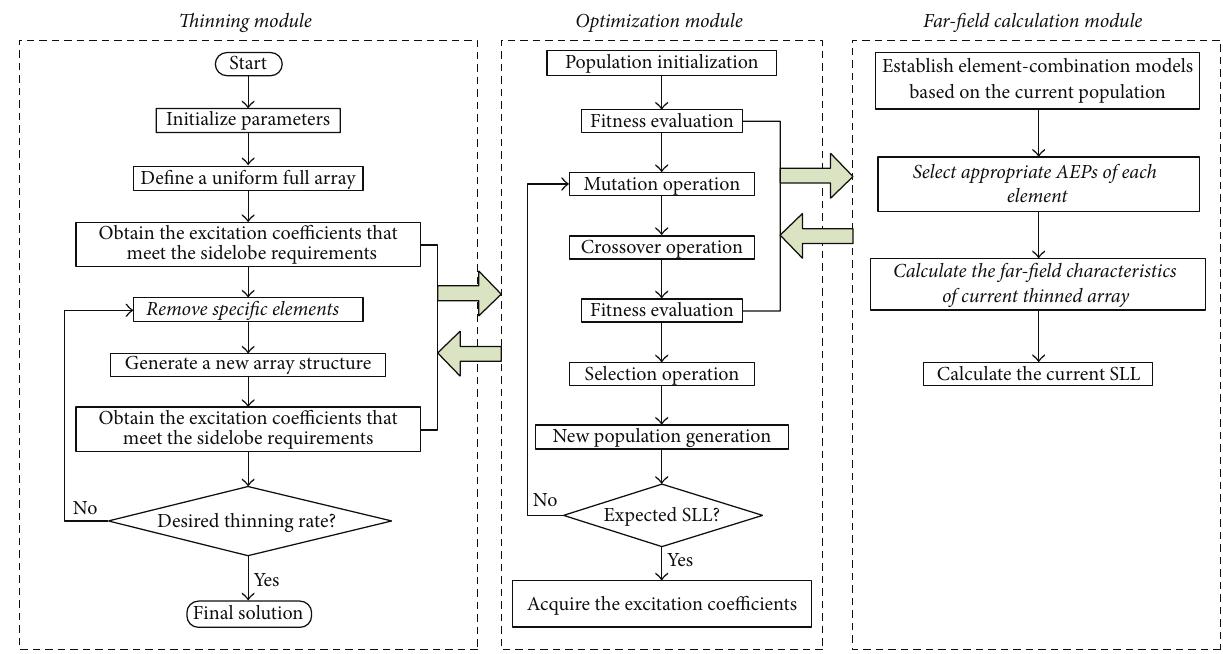
Figure 1: Flowchart of the thinning and weighting